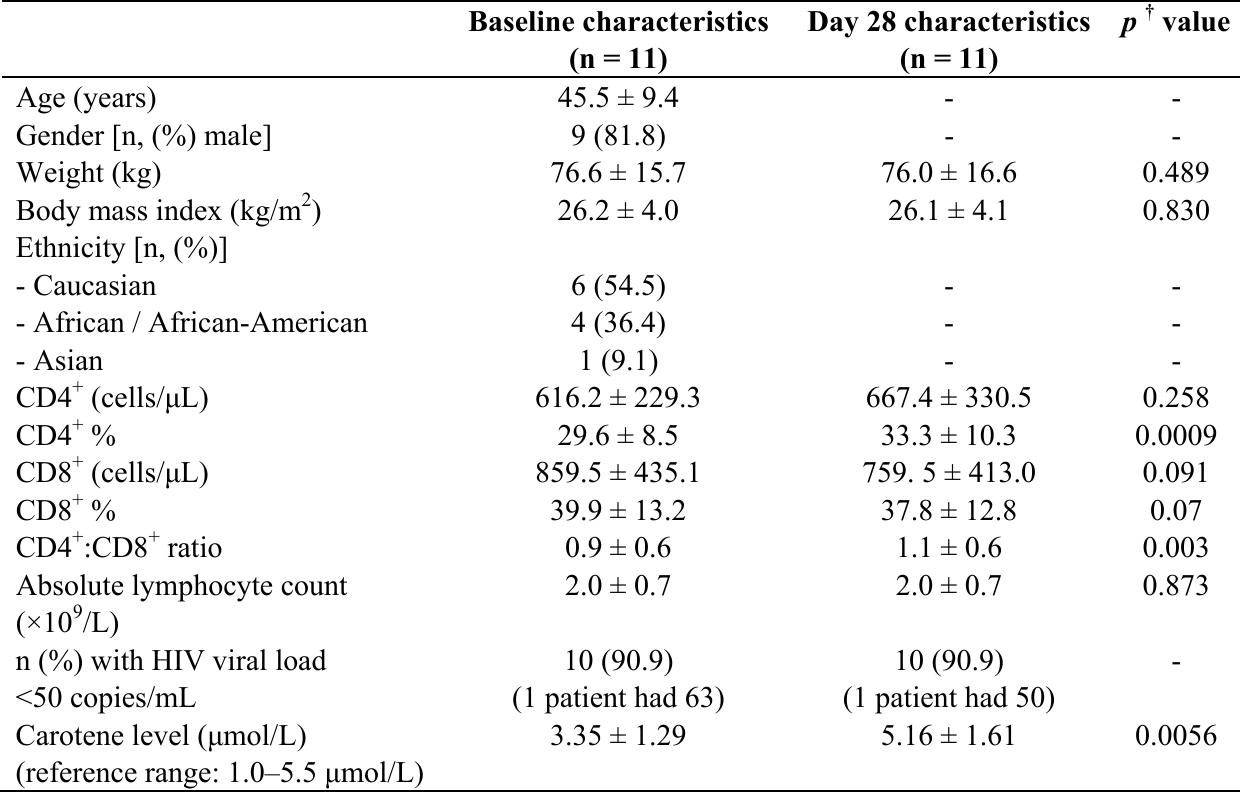
Table 1. Study population characteristics at baseline and after 28 days of β -carotene supplementation, 25,000 IU twice daily (n =